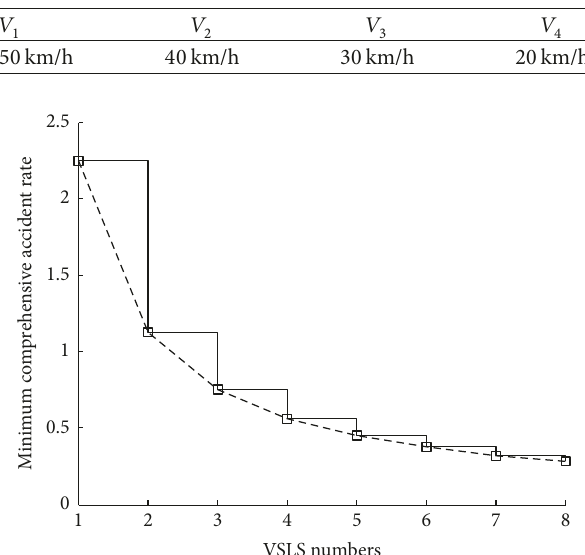
Table 2: Actual speed limits of the four VSLS.